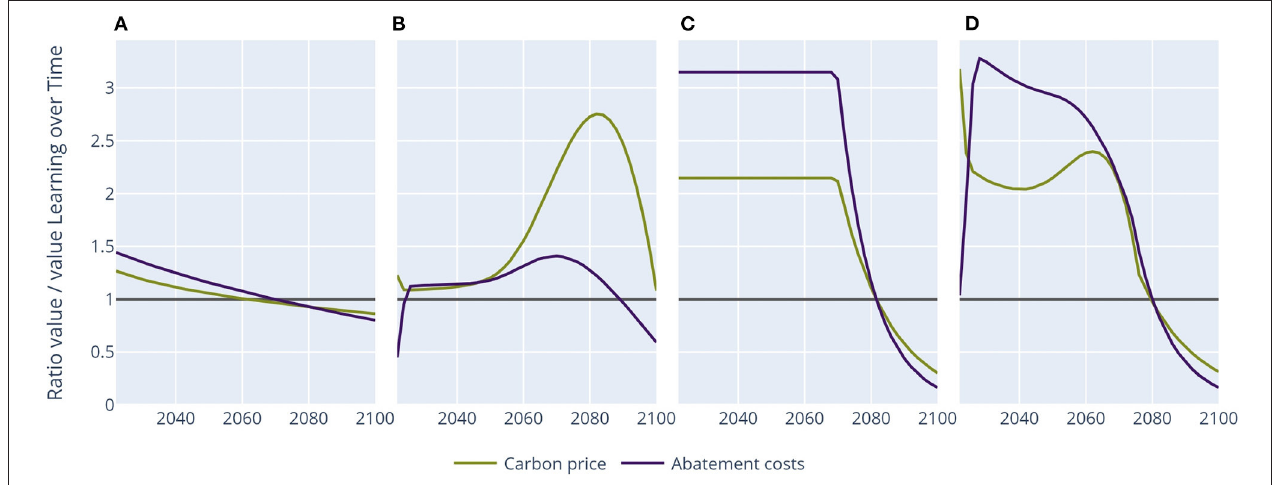
FIGURE 3 | Carbon price pathways and abatement costs relative to the learning over time pathway. (A) Learning by doing, (B) socio-economic inertia , (C) minimum emission level, and (D)